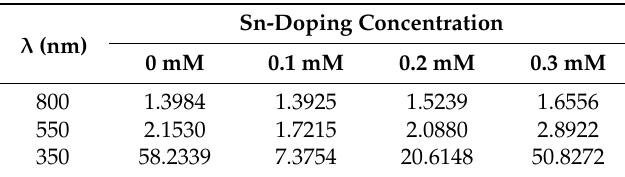
Table 4. Refractive index values of doped and un-doped CdO films prepared using 30 mL